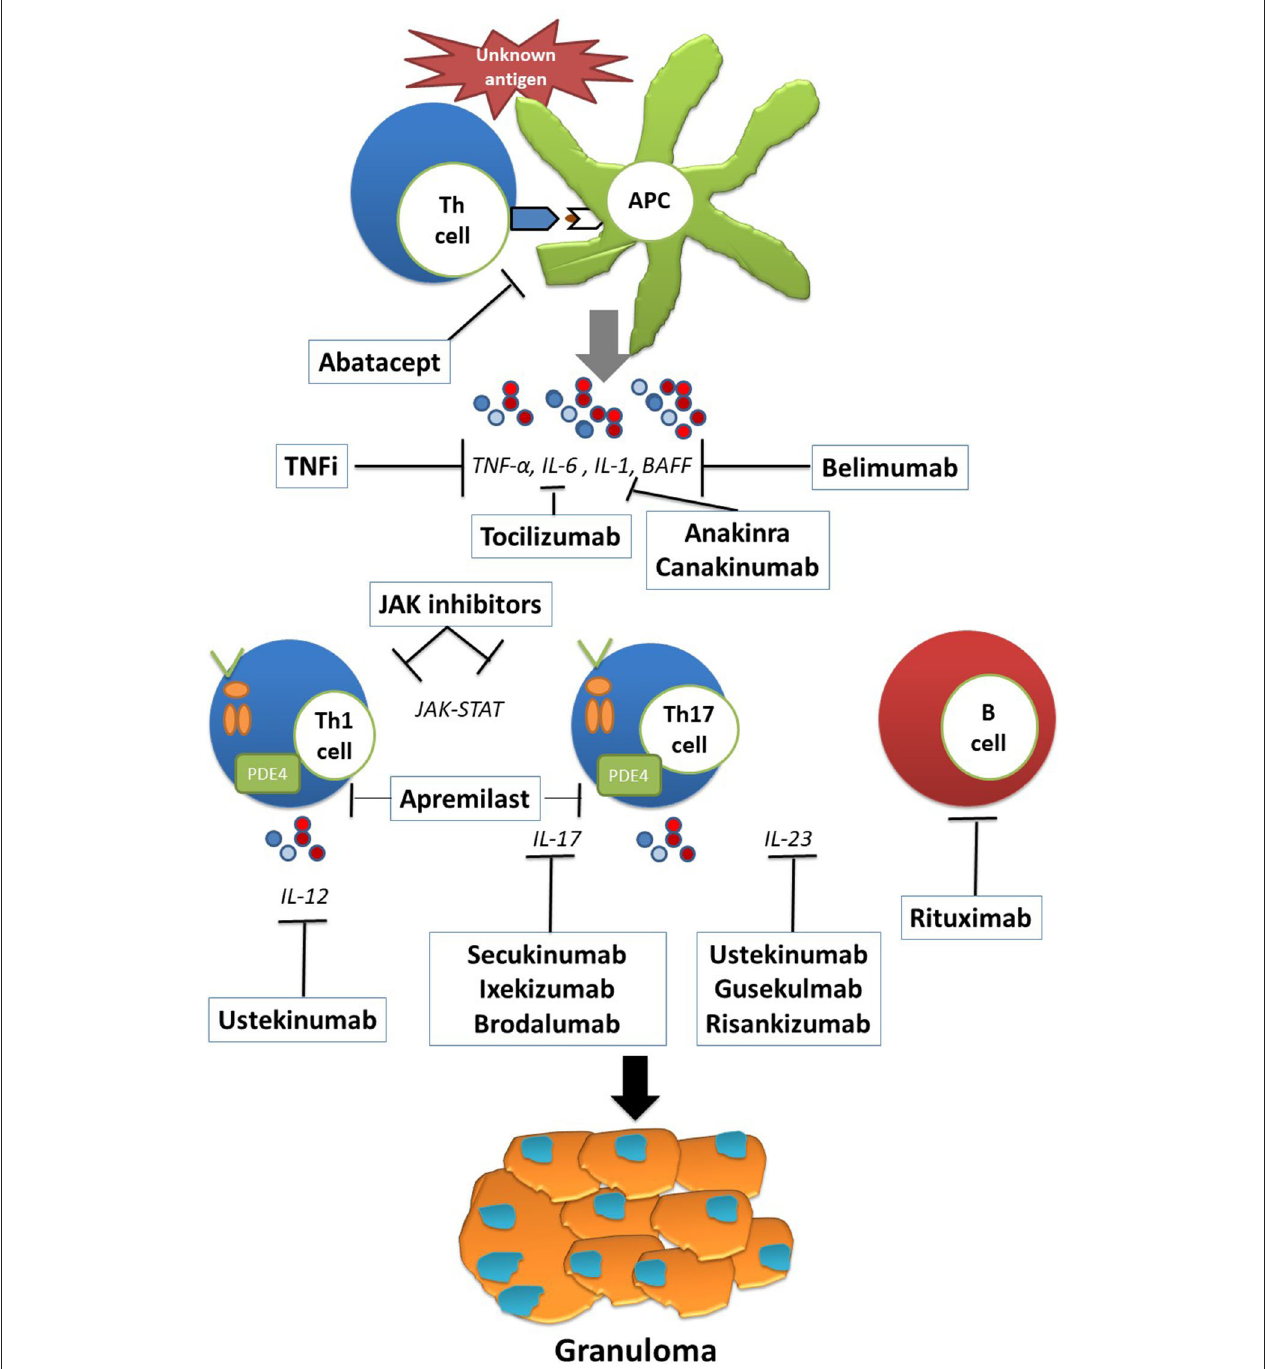
FIGURE 1 | The pathophysiology and potential therapeutic targets of refractory sarcoidosis. Exposure to an unknown antigen leads to the activation and proliferation of T cells through antigen presenting cells (APCs). The release of proinflammatory cytokines such as IL-6, IL-1, and BAFF skews the immune response to Th1 and Th17 responses as well as B cell activation and proliferation. Persistent antigen presentation leads to granuloma formation and to the development of sarcoid lesions. Th, T-helper cell; APC, antigen presenting cell; IL, interleukin; BAFF, B lymphocyte stimulator; JAK, janus